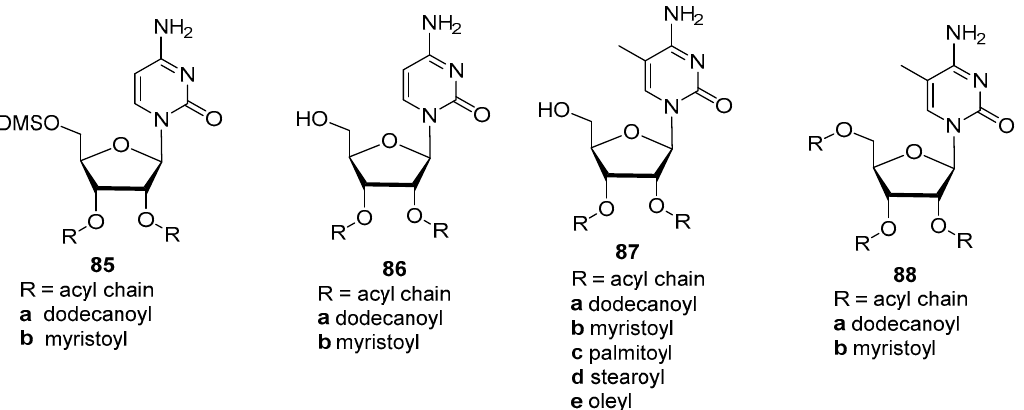
Figure 51. Conjugated cytidine and ribothymidine derivatives